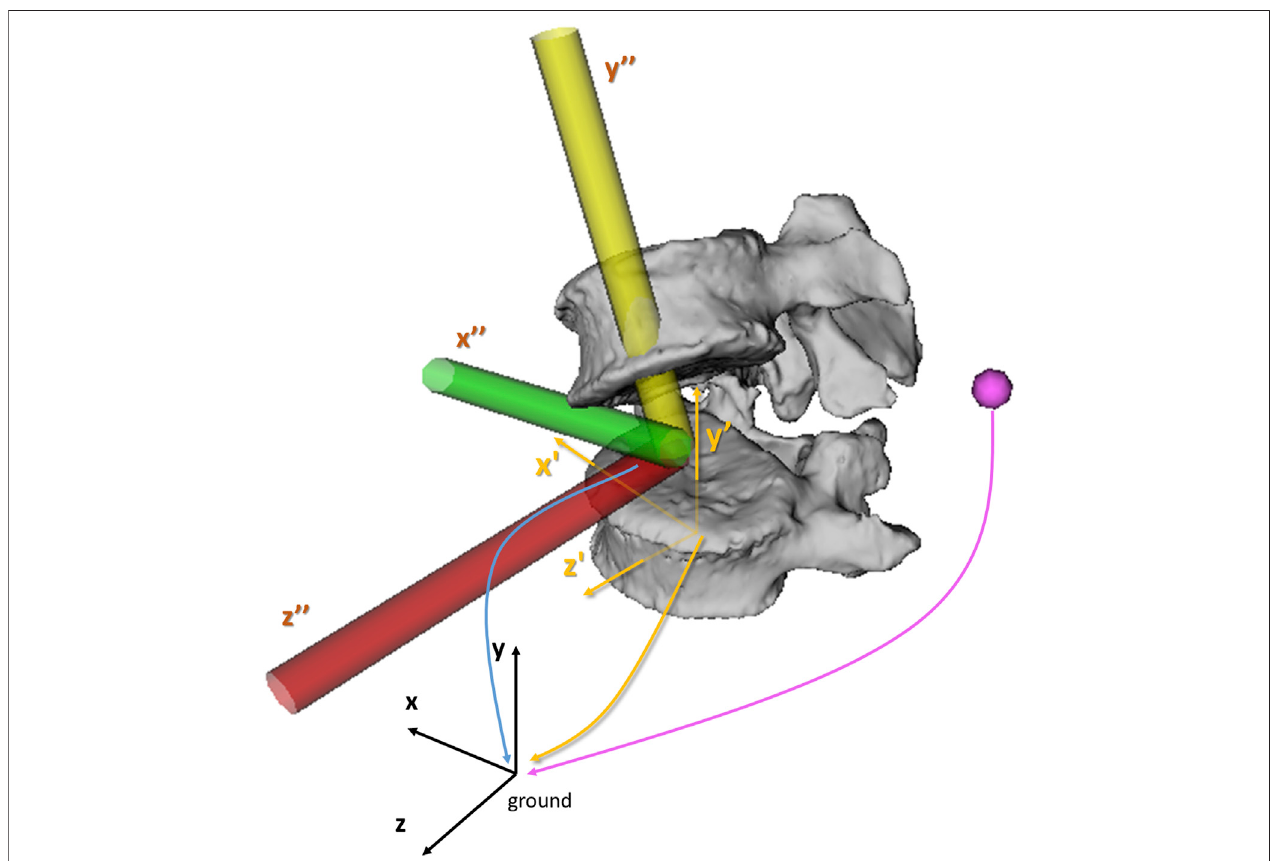
FIGURE 1 | Illustration of the three operator-dependent parameters components. The position of the virtual markers (pink sphere), the position and orientation of the bodies (yellow reference frame, x ’ y ’ z ’ ) and the position and orientation of the IV joints (yellow, green and red reference frame, x ” y ” z ” ) are expressed in the ground reference frame (black, xyz). Within the model, positions of virtual markers, bodies and joints, are expressed in the x (mediolateral), y (inferosuperior) and z (posterior- anterior) directions. The orientations of the joints and bodies are expressed around the x ( fl exion-extension, FE), y (axial rotation, AR) and z-axis (latero fl exion, LF) using an xyz body- fi xed sequence.